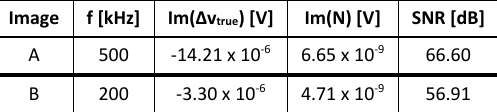
Table 7: Some quantitative data on the true signals Im(Δ v true ) relevant to the true images Im(Δ σ true ) in figure (9).